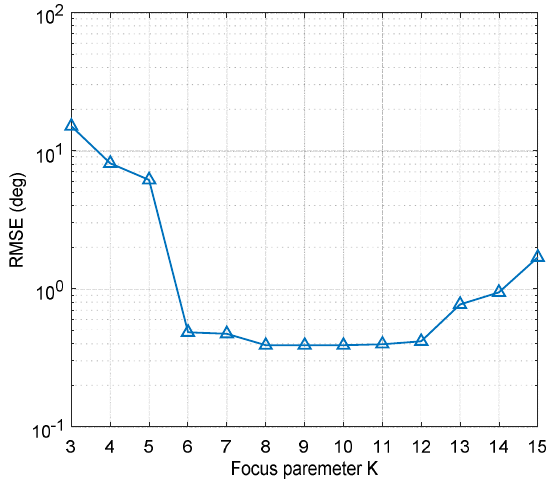
ff erent focusing